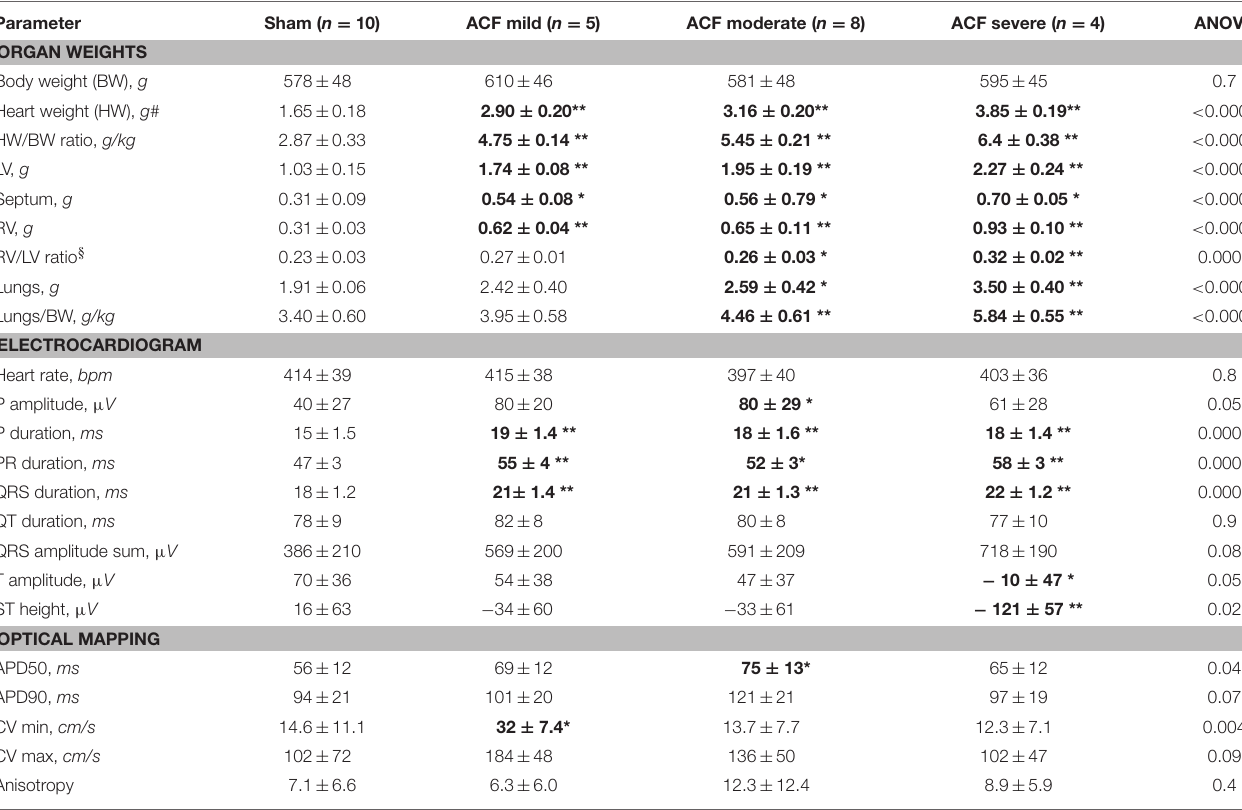
TABLE 1 | Summary of averages of all measured parameters by group (according to HBWR).